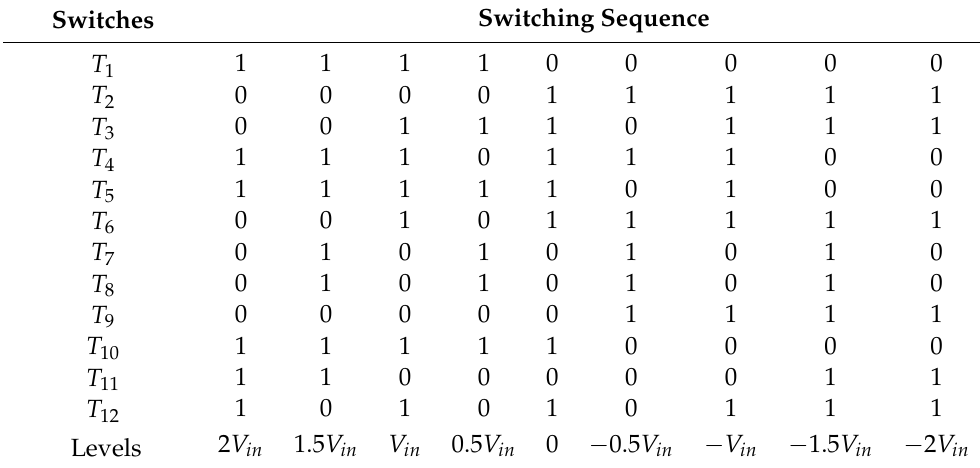
Table 2. Switching States of DB9LI.